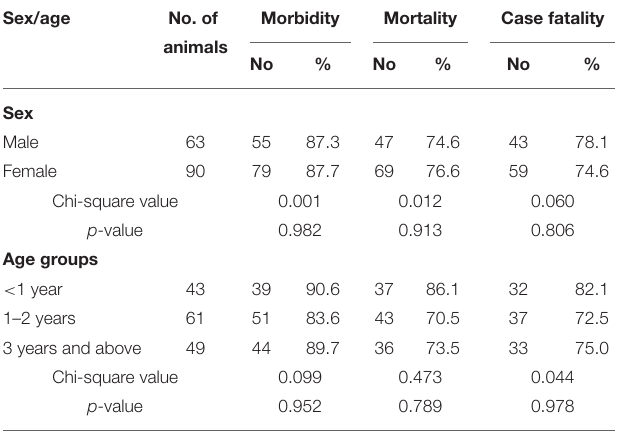
TABLE 3 | Overall morbidity, mortality, and case fatality in goats that died of enterotoxemia on the basis of sex and age.